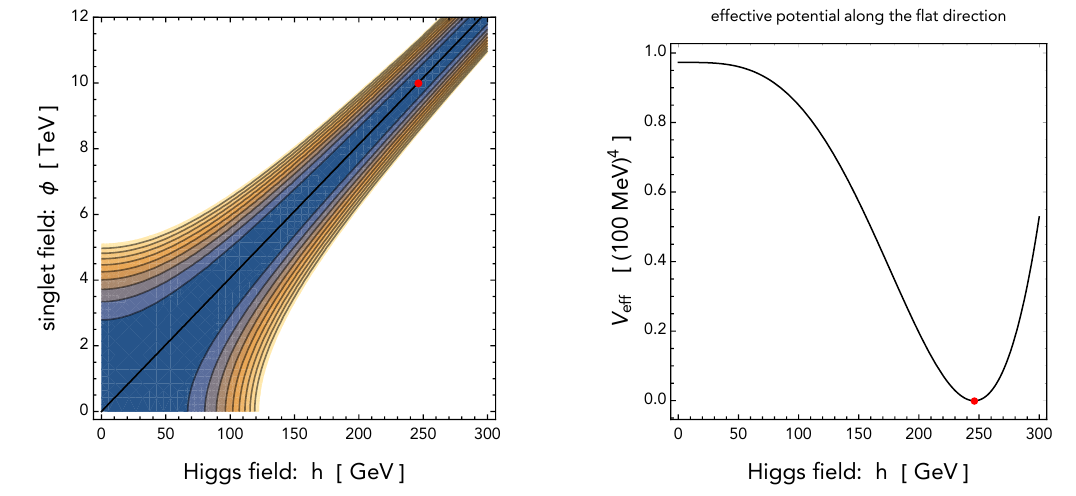
Figure 4 . The left panel shows a contour plot of the e(cid:11)ective potential as a function of h and (cid:30) . The diagonal direction is an approximately-(cid:13)at direction. The red point is the location of the global vacuum with h = 246 GeV and (cid:30) = 10 TeV. The right panel shows the e(cid:11)ective potential p along the (cid:13)at direction with (cid:30) = (cid:0) 2 (cid:21) h =(cid:21) mix h as a function of the Higgs